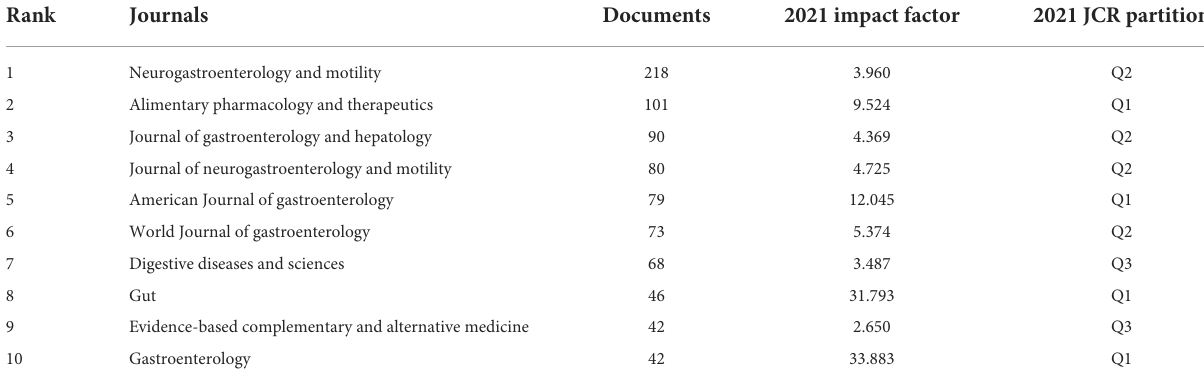
TABLE 4 Top 10 journals of publications about